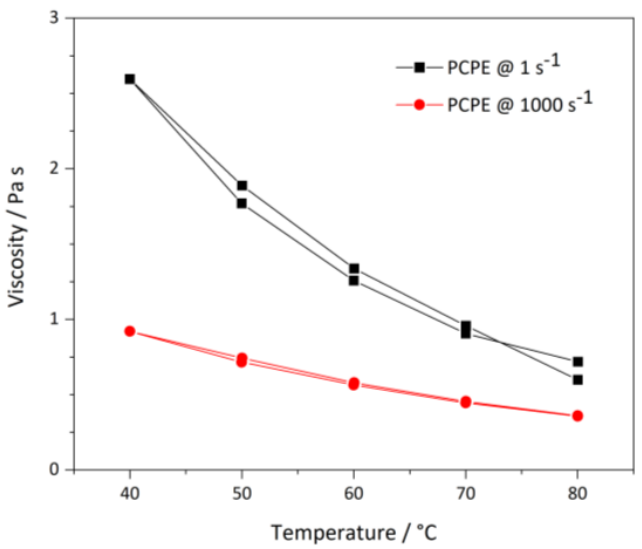
Figure 2. Temperature dependent viscosity of the PCPE at 1 s − 1 and 1000 s − 1 sheer rate; two measurements each.